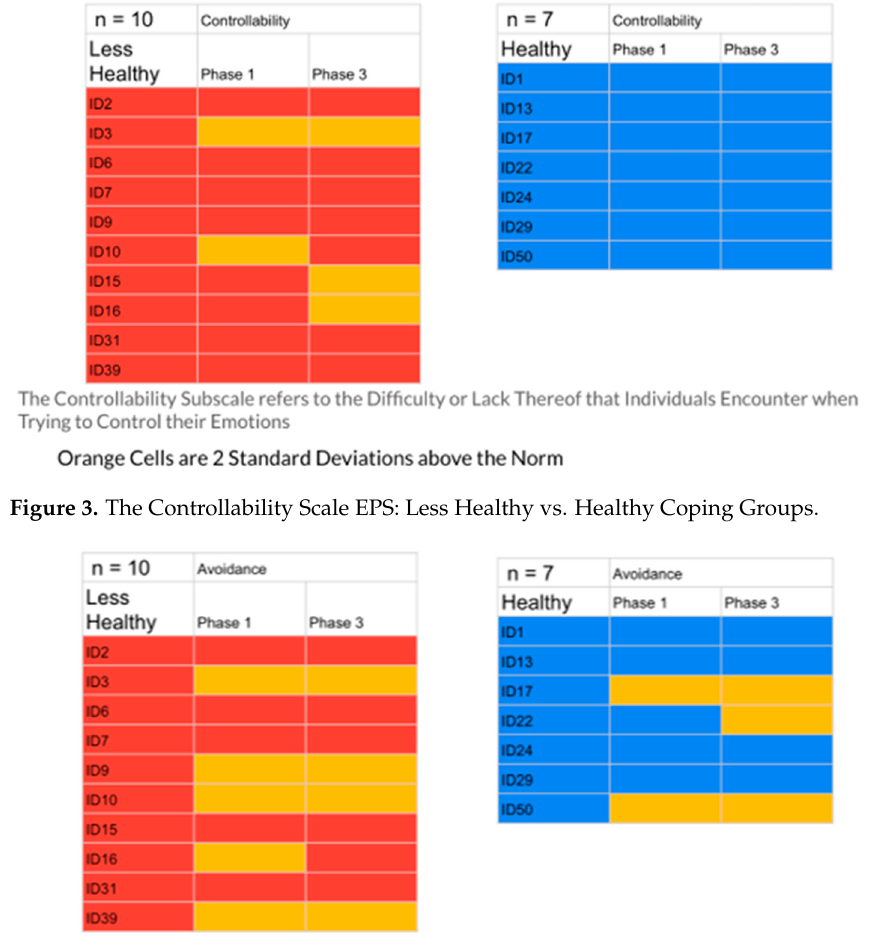
Figure 2. The Unprocessed Scale EPS: Less Healthy vs. Healthy Coping Groups.